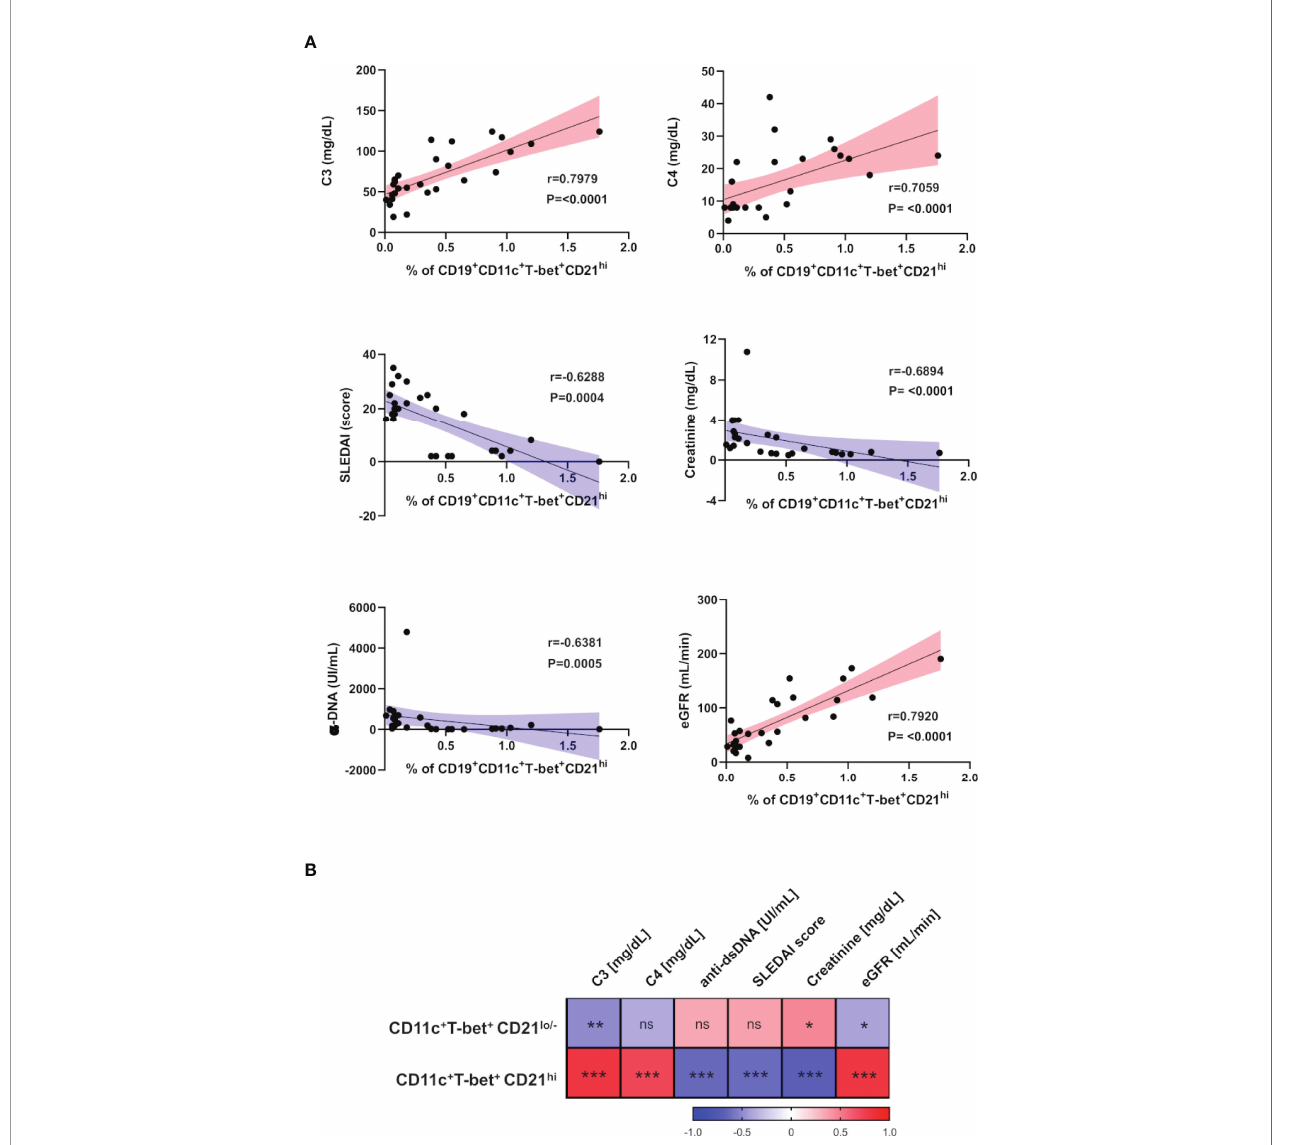
FIGURE 2 | ABCs and CD21 hi B cell subsets correlate with different clinical and laboratory parameters in SLE. (A) Correlation analysis between peripheral CD21 hi subset and levels of C3/C4, SLEDAI score, a -dsDNA, serum creatinine and estimated-GFR. The blue slopes (gradient) present negative correlations and red ones represent positive correlations. All graphs show calculated Spearman ’ s coef fi cient (r) and p values (all signi fi cant). (B) Correlation matrix showing a graphical representation of calculated Spearman ’ s coef fi cient calculations between the B cell subset frequencies and clinical and laboratory variables of non-LN patients (n=10) and LN patients before the induction therapy (n=17). The underlying color scale indicates Spearman ’ s coef fi cient values. ns, not statistically signi fi cant. *p ≤ 0.05 **p ≤ 0.01 ***p ≤